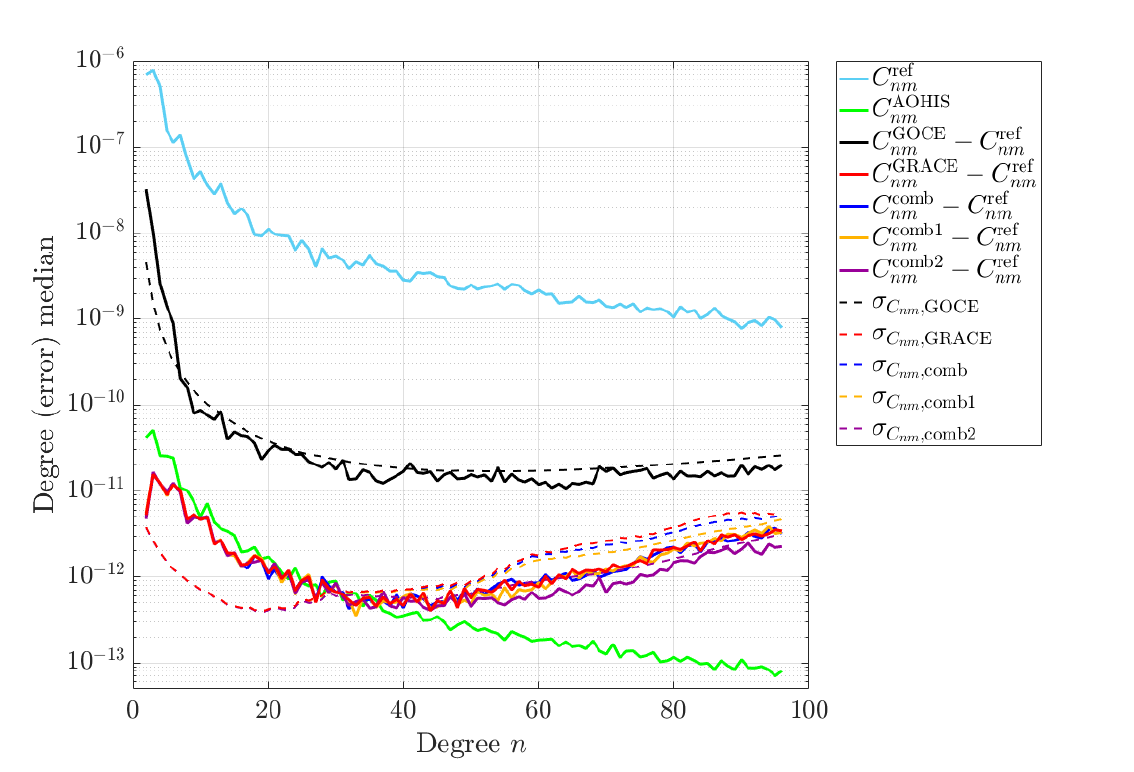
Figure 17. Degree error medians of the monthly SH d/o 96 gravity field models for September 2011 that are shown as EWH grids in the Figures 15 and 16. The individual model names are explained in Section 3.3.2. For comparison, the degree median of the static and trend part of the GOCO06s model [9] at the reference epoch 15 September 2011 (“ref”) as well as the degree median of the AOHIS model coefficients [35] for September 2002 are shown. For the degree error median curves, solid lines represent degree median values of coefficient differences of the individual models to the reference “ref” while dashed lines represent degree median values of formal coefficient 1-sigma